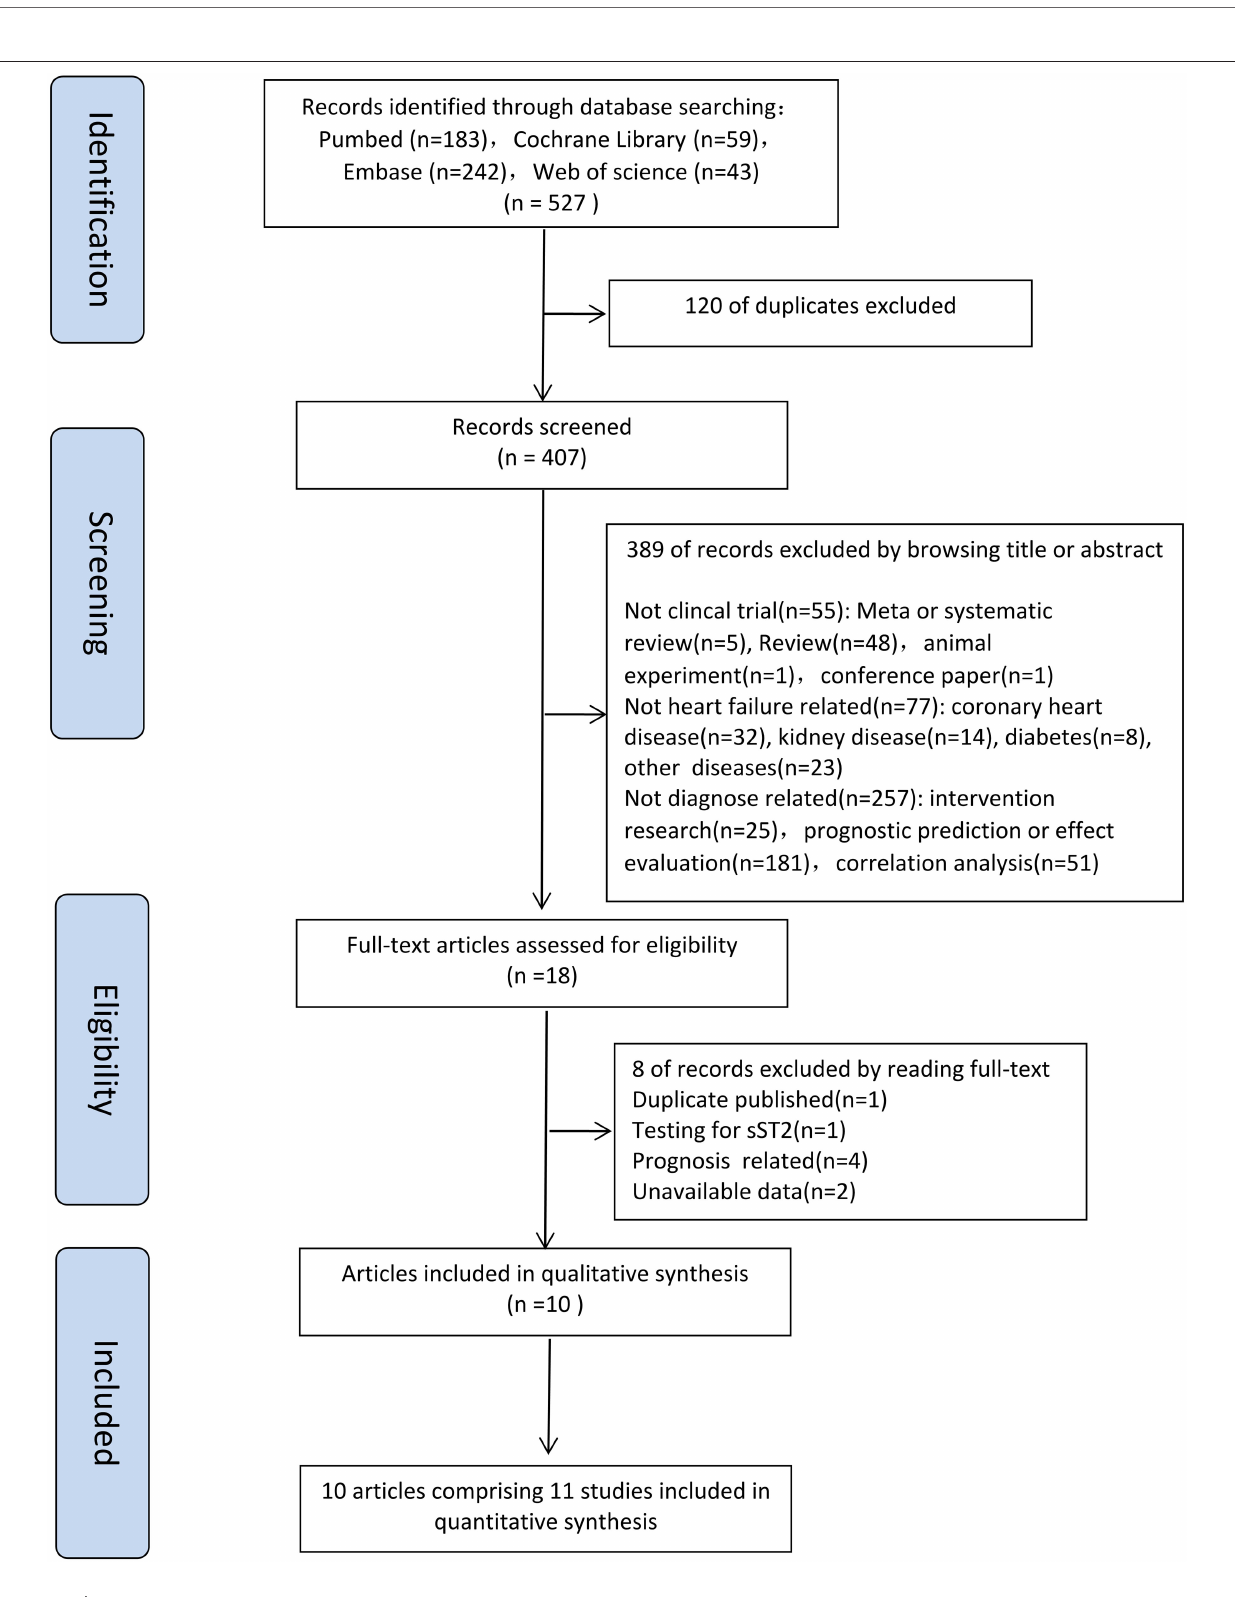
FIGURE 1 | Flow diagram for study